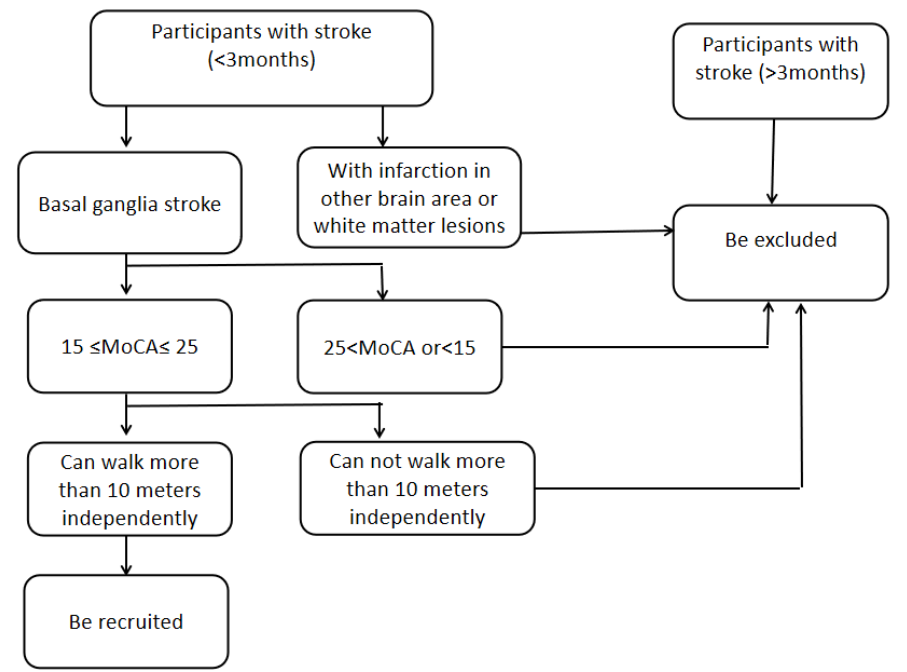
Figure 1. Recruitment flow chart.